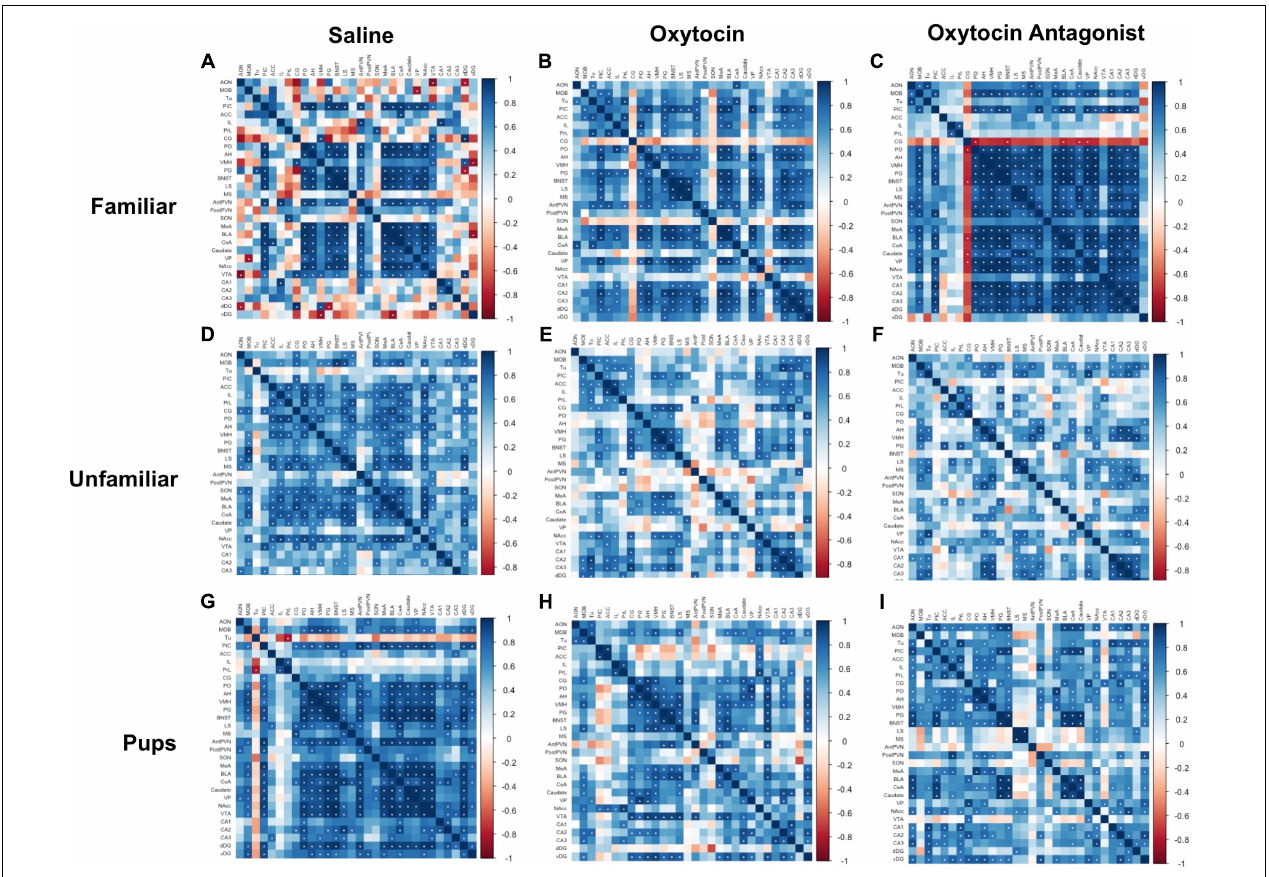
FIGURE 4 | Correlation matrices separated by behavioral paradigm and OT manipulation. Pair-wise Pearson correlations were calculated for c-Fos cell counts and all correlations plotted. Statistically significant correlations are marked by a white asterisk. (A) Saline-treated FAM, (B) OT-treated FAM, (C) OTA-treated FAM, (D) saline-treated UNFAM, (E) OT-treated UNFAM, (F) OTA-treated UNFAM, (G) saline-treated PUP, (H) OT-treated PUP, and (I) OTA-treated PUP. AON, anterior olfactory nucleus; MOB, main olfactory bulb; Tu, olfactory tubercle; PIC, piriform cortex; ACC, anterior cingulate cortex; PrL, pre-limbic cortex; IL, infralimbic cortex; CG, cingulate cortex; PO, pre-optic area; AH, anterior hypothalamus; VMH, ventromedial hypothalamus; PG, periaqueductal gray; BNST, bed nucleus of the stria terminalis; LS, lateral septum; MS, medial septum; AntPVN, anterior paraventricular nucleus; PostPVN, posterior paraventricular nucleus; SON, supraoptic nucleus; MeA, medial amygdala; BLA, basolateral amygdala; CeA, central amygdala; Caudate, caudate putamen; VP, ventral pallidum; NAcc, nucleus accumbens; VTA, ventral tegmental area; CA1, cornu ammonis 1; CA2, cornu ammonis 2; CA3, cornu ammonis 3; dDG, dorsal dentate gyrus; vDG = ventral dentate